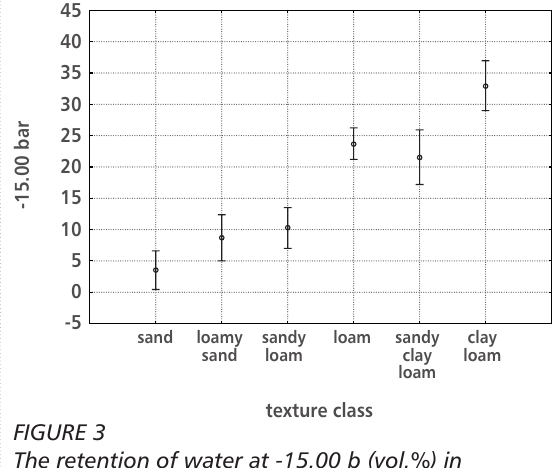
The retention of water at -15.00 b (vol.%) in comparison with the textural